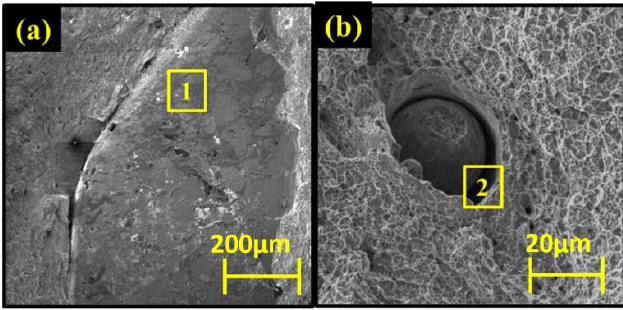
Figure 21: (a) Unfused L-PBF layer (label 1) and (b) Delaminated layer between the spherical contaminant and the material matrix (label 2) on the fractured surface of sample 17B (213.2 J/mm). This sample fractured in the weld zone